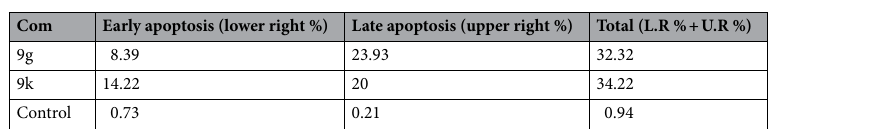
Table 4. Distribution of apoptotic cells within MDA-MB-231 cell line upon treatment with 9g and 9k , using AnnexinV-FITC/PI assay.